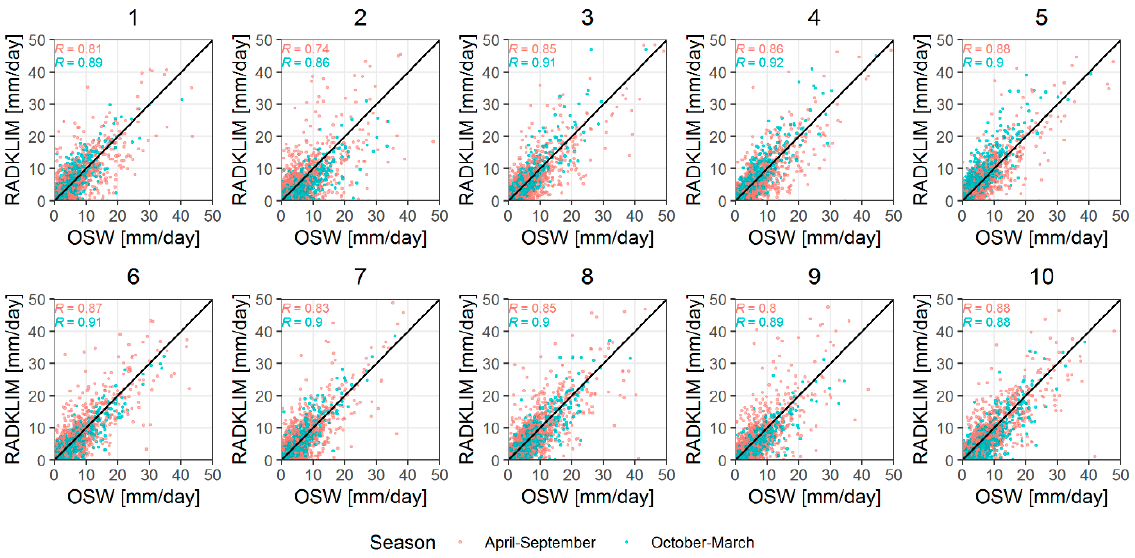
Figure 8. The correlation of daily precipitation from OSW and RADKLIM for the ten selected catchment in the study period (2001–2017) within the value range from 0 to 50 mm/day. Two seasons were examined, namely summer (red points) and winter (blue points).